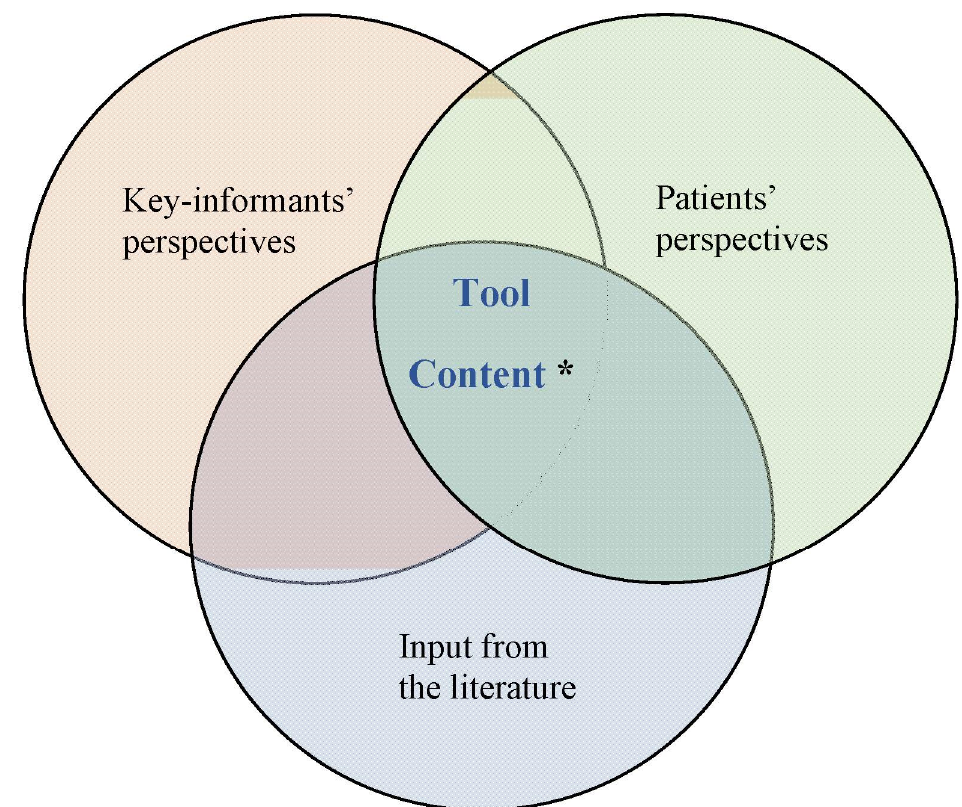
Figure 3. Three main sources for the VAHLT development for conceptualization: key-informants’ perspectives, patients’ perspectives, and input from the literature. The asterisk ‘*’ indicates the common prespectives of patients and key-informants that matched with the literature were selected and applied in the development of our health literacy tool framework.